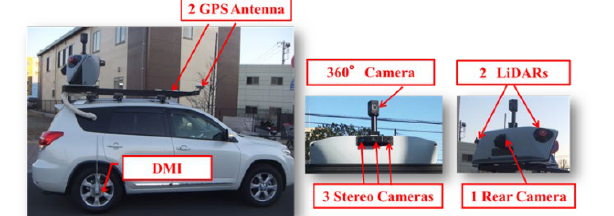
Figure 2. Our MMS vehicle, Cameras and LiDARs